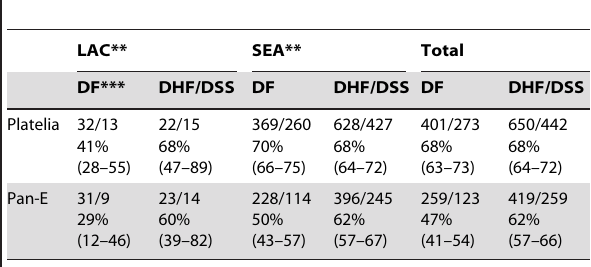
Table 6. Sensitivity of Kit Platelia and Pan-E by geographic region and disease